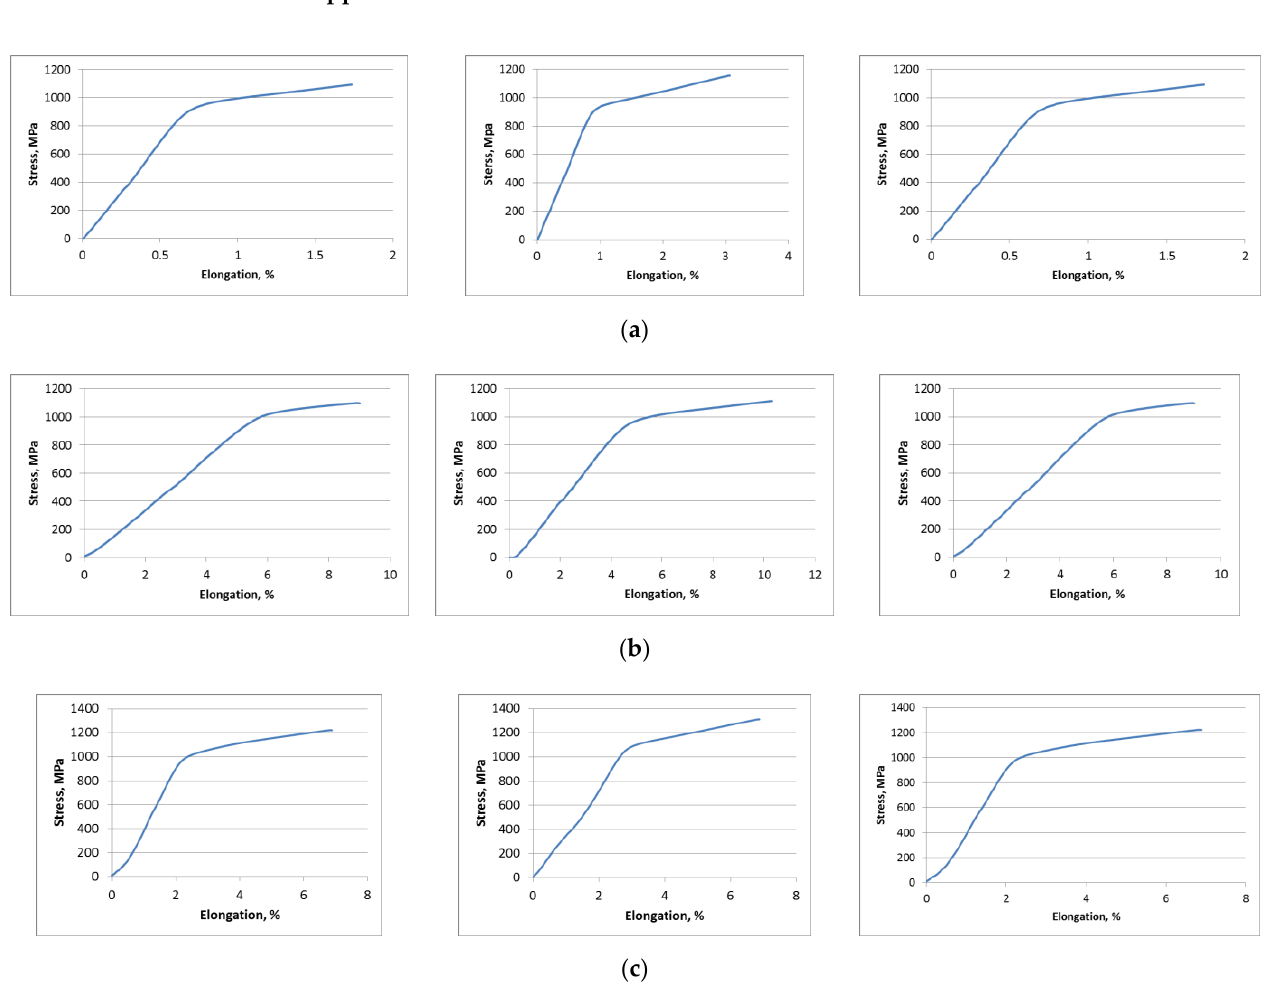
Figure A1. Raw stress-strain diagrams for the three regions under study — ( a ) initial material, ( b ) transition area, ( c ) repaired area. Three samples were tested for each area.